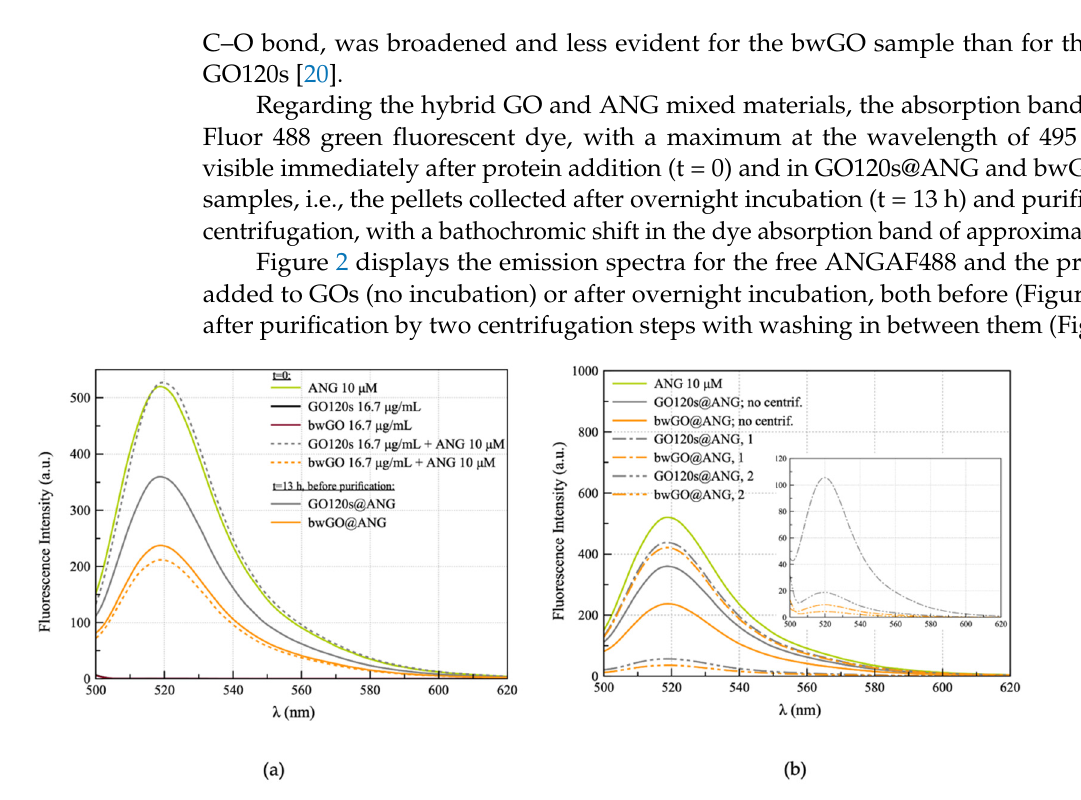
Figure 2. Emission spectra ( λ ex = 488 nm) for ( a ) ANGAF488 (10 μ M), GO120s and bwGO sheets (16.7 μ g/mL GO), the hybrids immediately after the addition of the protein to the GOs (GO + ANG, t = 0, dashed lines) and after overnight incubation, before purification (GO@ANG, t = 13 h, solid lines); ( b ) nanohybrids GO@ANG before purification and supernatants collected after the two steps of centrifugation (the correspondent pellets are reported in the inset).